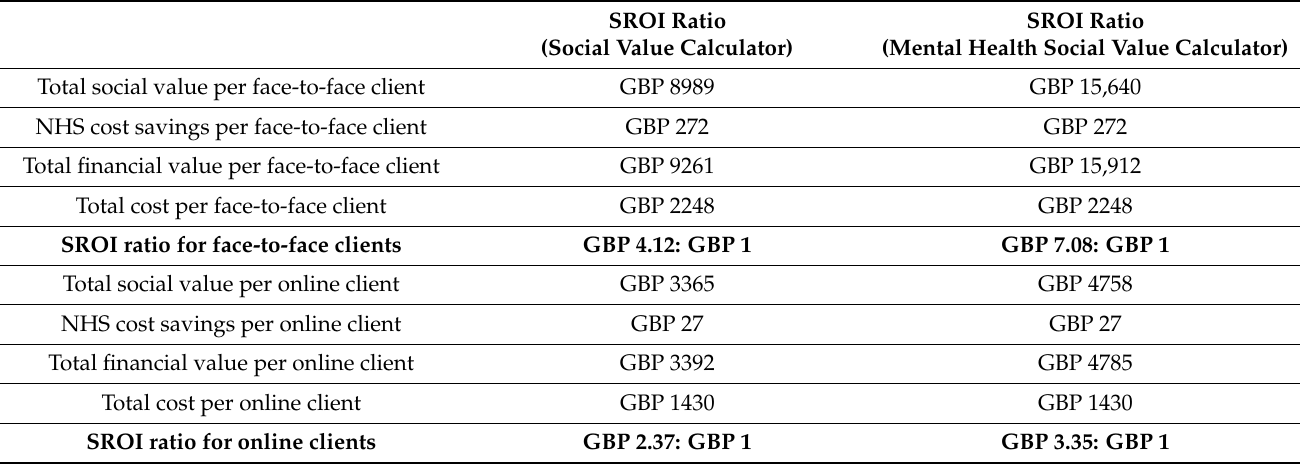
Table 10. SROI ratios using the social value calculator and the mental health social value calcula- tor. SROI Ratio SROI Ratio (Social Value Calculator) (Mental Health Social Value Calculator)